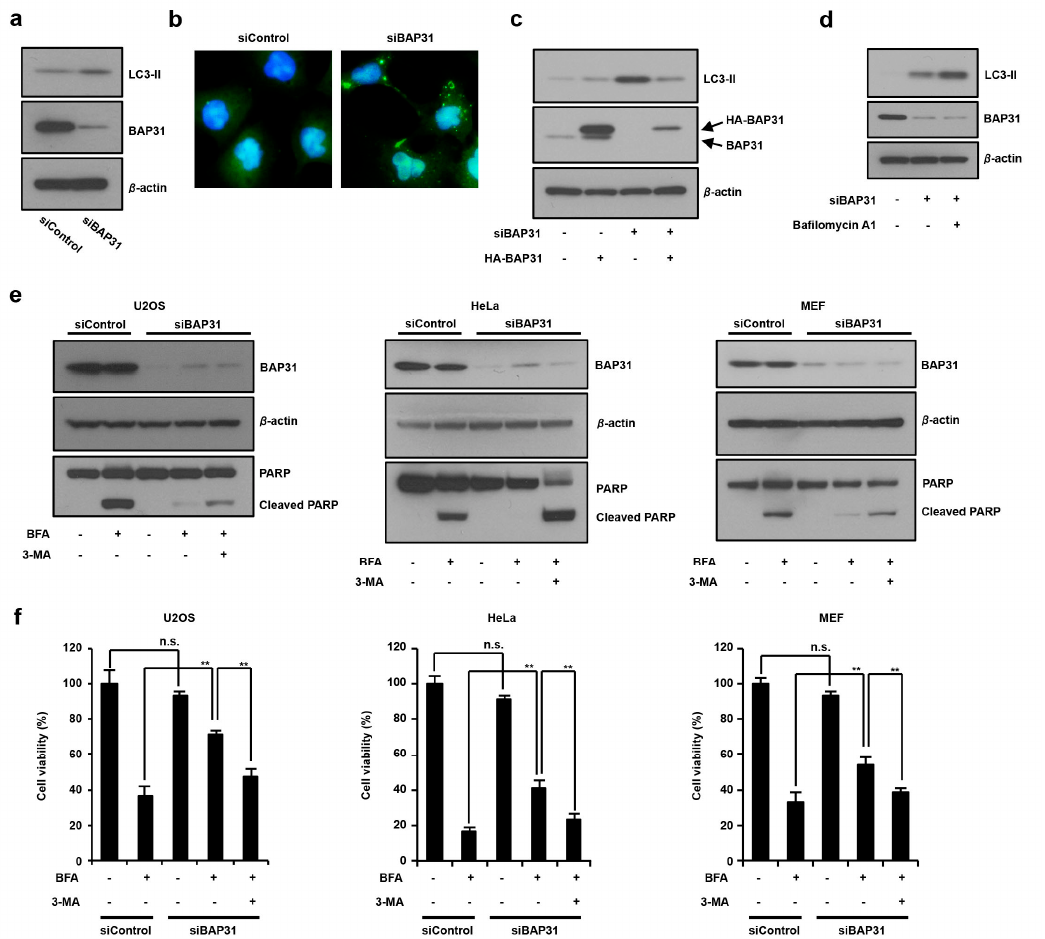
Figure 2. The suppression of BAP31 expression induces autophagy and antagonizes ER stress-induced cell death. ( a ) Loss of BAP31 increases LC3-II expression. U2OS cells were transfected with 150 pmol of siBAP31 or siControl for 24 h. Cells were subjected to immunoblotting using anti-BAP31, anti-LC3, and anti- β -actin antibodies. ( b ) U2OS cells stably expressing GFP-LC3 were transfected with 150 pmol of siBAP31 or siControl for 24 h. Cells were fixed with 4% PFA, and GFP-LC3 (green) fluorescence was determined. Blue represents nuclear DAPI staining. Scale bar, 10 µ m. ( c ) U2OS cells were transfected with siBAP31 ( + ) or siControl ( − ) for 18 h and then transfected with HA-BAP31 ( + ) or pcDNA3.1 ( − ) for 12 h. Cells were subjected to immunoblotting using indicated antibodies. ( d ) BAP31 knockdown stimulates autophagosome synthesis. U2OS cells were transfected with 150 pmol of siBAP31 or siControl for 24 h, followed by treatment with or without 1 µ g / mL of bafilomycin A1 for 1 h. Cells were subjected to immunoblotting using the indicated antibodies. ( e , f ) The suppression of BAP31 inhibits ER stress-mediated cell death by inducting autophagy. The cells were transfected with siBAP31 or siControl for 16 h and these cells were preincubated with or without 5 mM of 3-MA for 1 h and further incubated with or without BFA (1 µ g / mL) for 18 h in U2OS, HeLa, and MEF cells. Cells were subjected to immunoblotting using the indicated antibodies ( e ) or MTT using cell viability assay ( f ). These experiments were repeated two times ( a – e ). Data are presented as the mean ± standard deviation (SD) of the three simultaneously performed experiments ( f ). P values were calculated using two-way ANOVA; n.s., not significant; ** P < 0.01 ( f ).